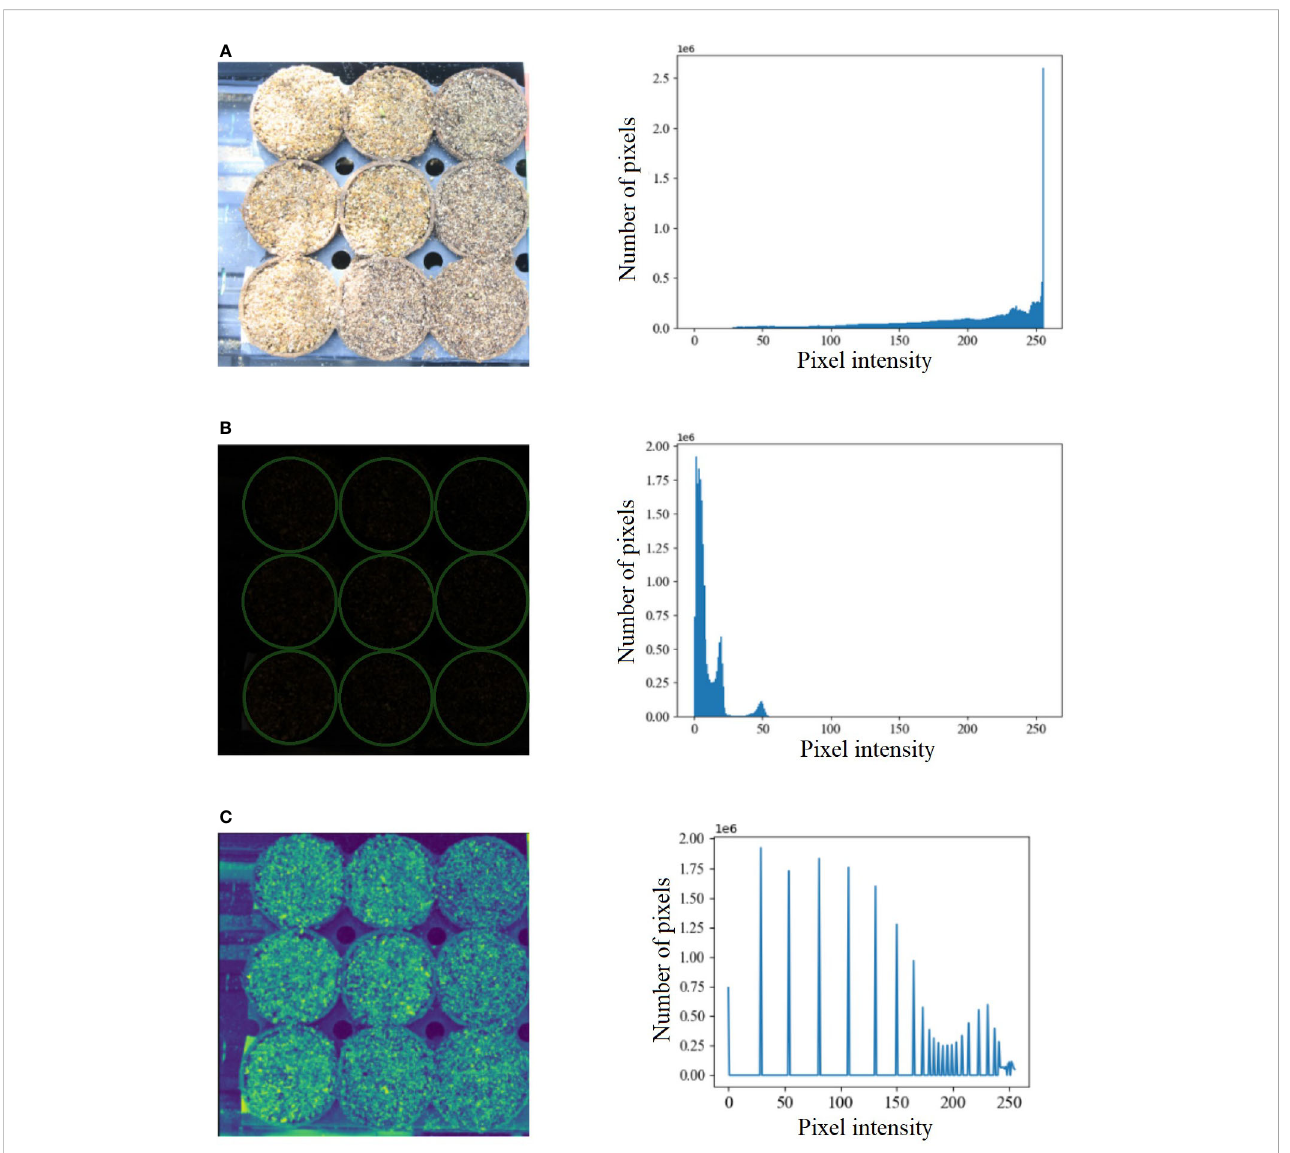
FIGURE 1 (A) An example of the brightest image from UNL-MED and its corresponding histogram; (B) an example of the darkest image from UNL-MED (the pots are marked in green circles) and its corresponding histogram; and (C) the darkest image after histogram equalization and its corresponding